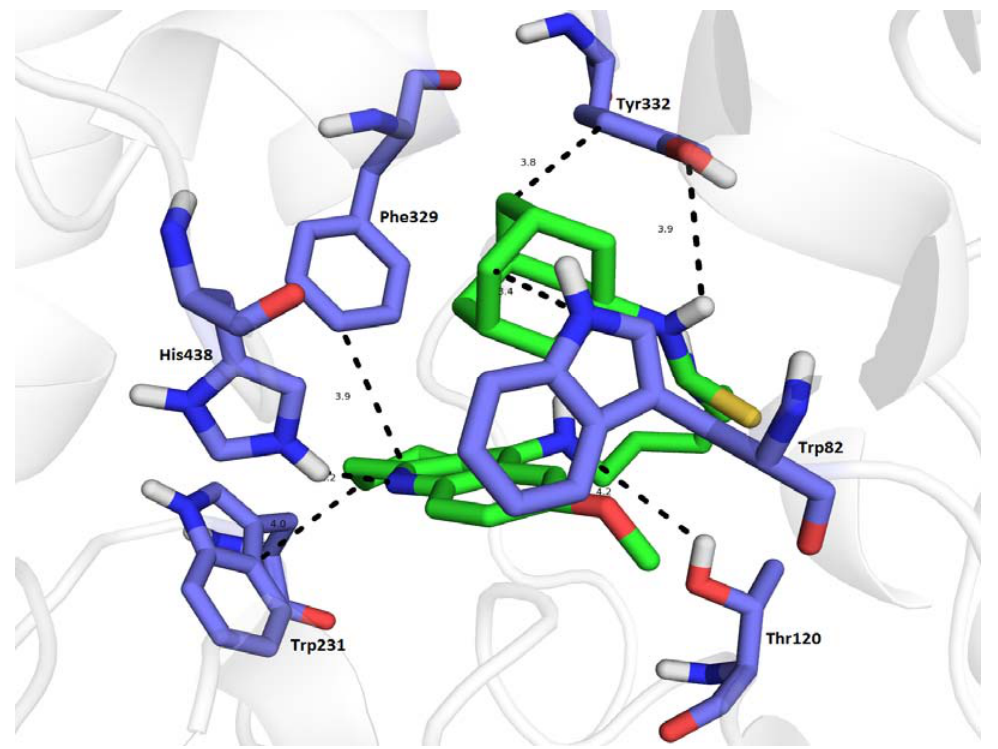
Figure 6. Docked complex of 14 (green) in the hBChE active site. Interaction with key amino acid residues (blue) are highlighted by black dashed lines. The rest of hBChE is illustrated as cartoon for